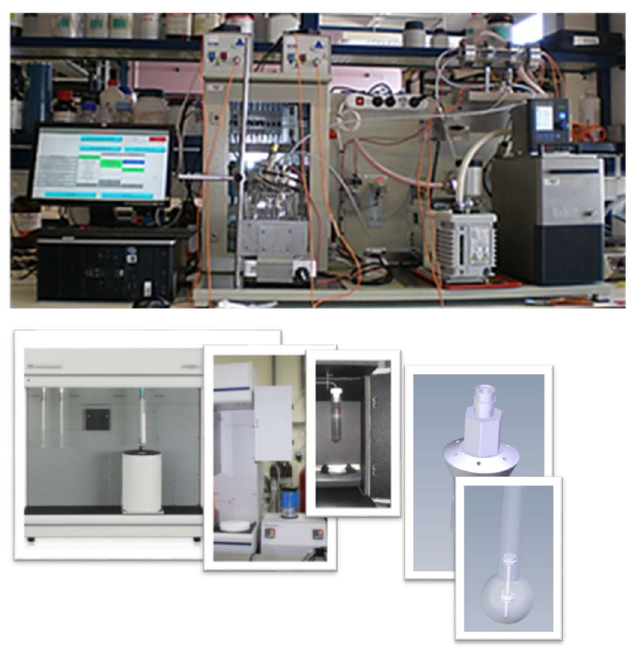
Figure 4. ( a ) A third-generation calibration system designed by the IC team at the UPNA; ( b ) a fourth-generation calibration system (adapted from a Micromeritics adsorption device for calibrating an FOS), currently in testing.